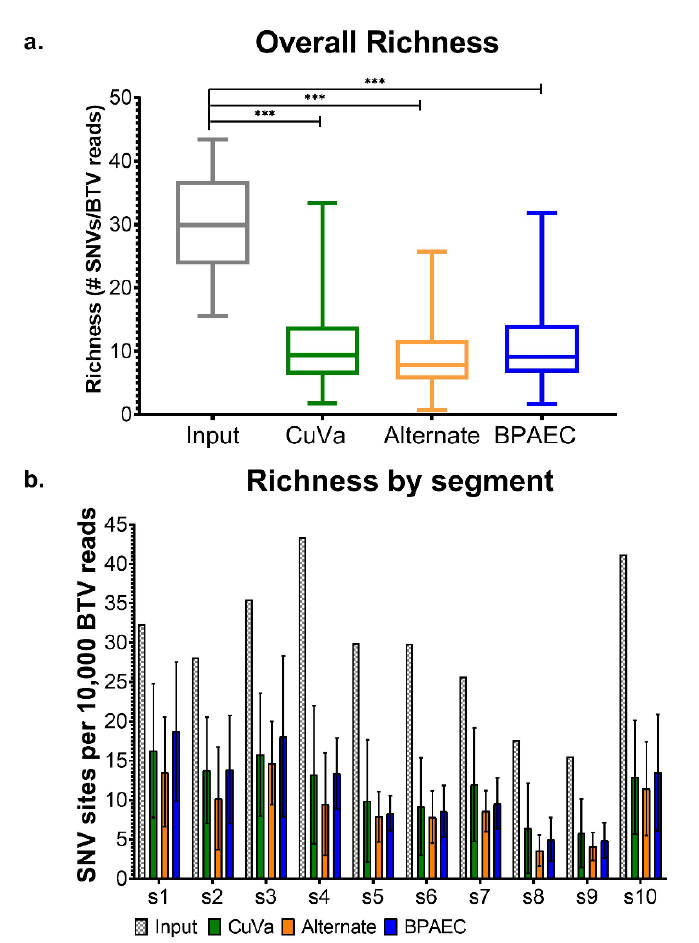
Figure 3. BTV Genetic Richness across Cell Culture Conditions. ( a ) Richness of each segment was calculated as the sum of single nucleotide variants (SNV) sites normalized by the number of BTV reads (i.e., variant sites per 10,000 BTV reads), and collective data across all segments are shown by box-and-whisker plots (median, interquartile range, and minimum / maximum are depicted; *** = p < 0.005). Box-and-whisker plots for BTV17-CUVA, -ALT, and -BPAEC were constructed using the richness of all segments across passages 3, 6, and 9. ( b ) Mean richness and standard deviation for each segment are shown. Segments 1–10 are represented along the x -axis (s1, s2, s3, s4, s5, s6, s7, s8, s9, and s10). Bars depicting BTV17-CUVA, -ALT, and -BPAEC represent collective data from passages 3, 6, and 9.